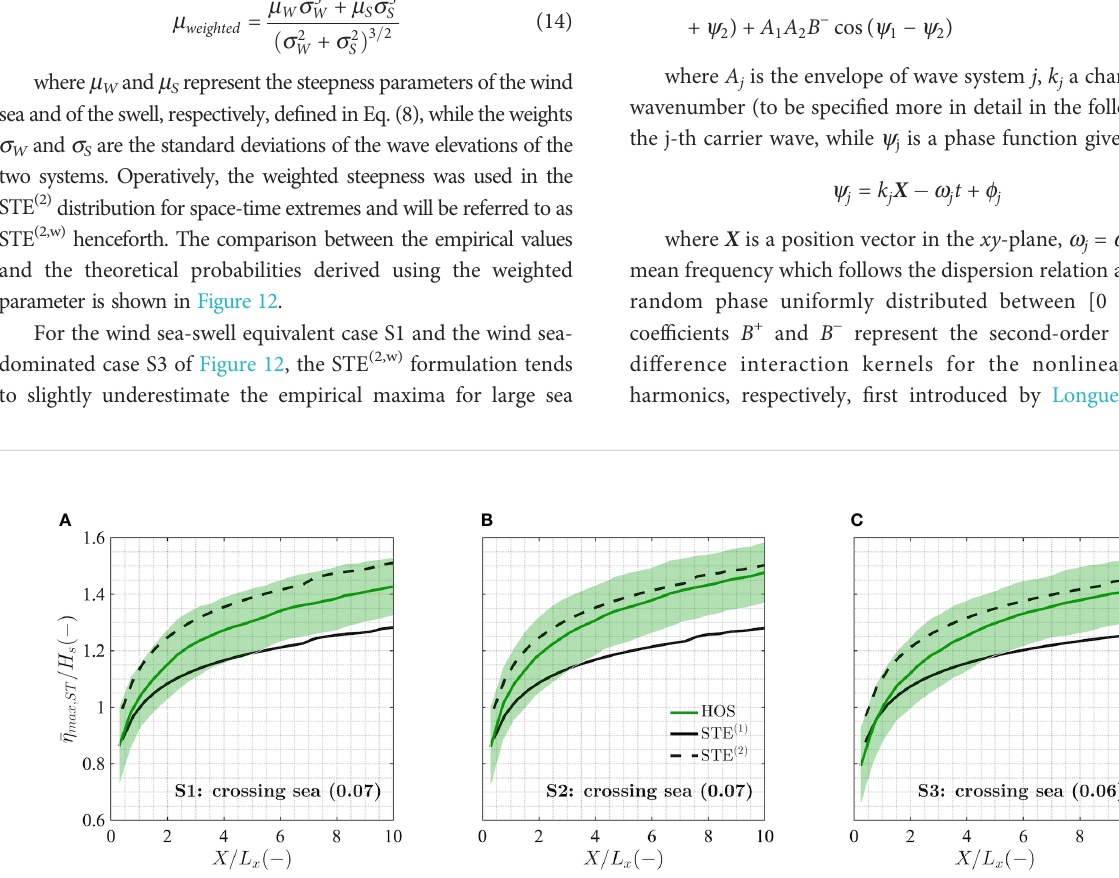
FIGURE 11 Empirical space-time mean values of normalized maximum wave crest height ( (cid:1) h max,ST /H s ) as a function of the normalized sea surface area width ( X/L x ) for crossing sea conditions S1 (A) , S2 (B) , and S3 (C) . The standard deviation of the empirical distributions (shaded area) is also shown. Reference statistical distributions for space-time extremes: linear (STE (1) , thick solid black) and second-order nonlinear (STE (2) , dashed black). In brackets we display the value of the steepness m